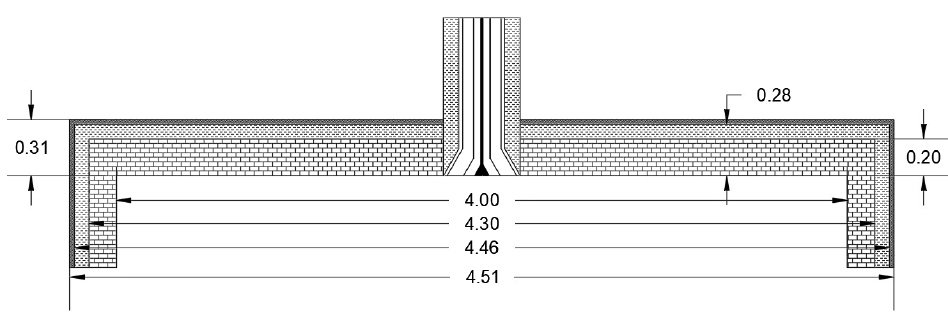
Figure 10. Reactor wall structure (unit in m). Table 4. Wall material